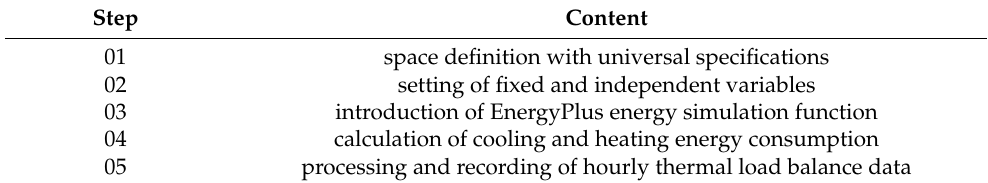
Table 1. Simulation process